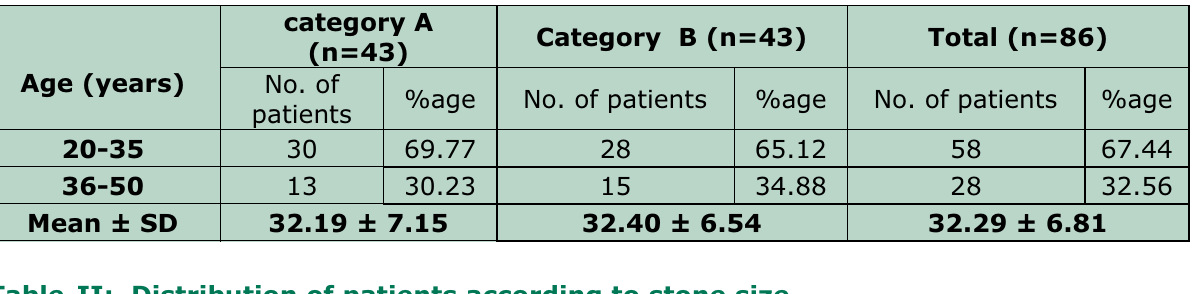
Table-II: Distribution of patients according to stone size. Stone size